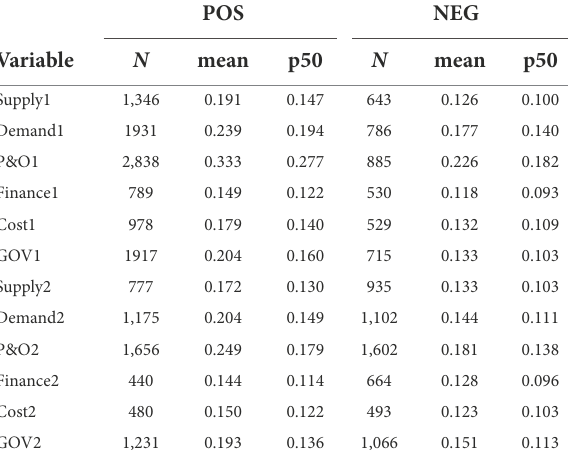
TABLE 9 COVID-19 impact, corporate cash holdings and six major